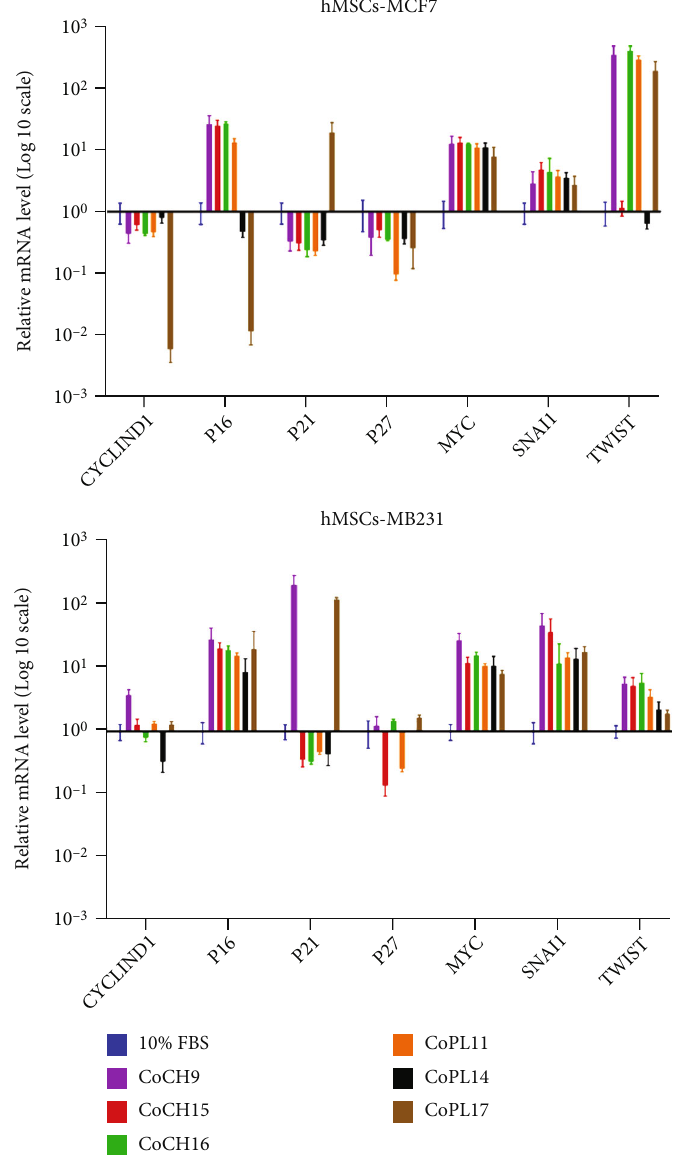
Figure 7: The e ff ect of hMSC-derived soluble factors on the gene expression of human breast cancer MCF-7 and MDA-MB231 cells. Gene expression levels in MCF-7 and MDA-MB231 cells cocultured with CH-hMSCs (coCH) and PL-hMSCs (coPL) using a transwell culture system as determined by qRT-PCR. CH-hMSCs were derived from 3 donors (CH9, CH15, and CH16), and PL-hMSCs were derived from 3 donors (PL11, PL14, and PL17). MCF-7 and MDA-MB231 cells cultured in DMEM medium +10% FBS (10% FBS) served as controls. The relative expression levels of the genes in each sample were standardized with the expression level of the same genes in the control samples. Data are presented as mean ± SEM of three